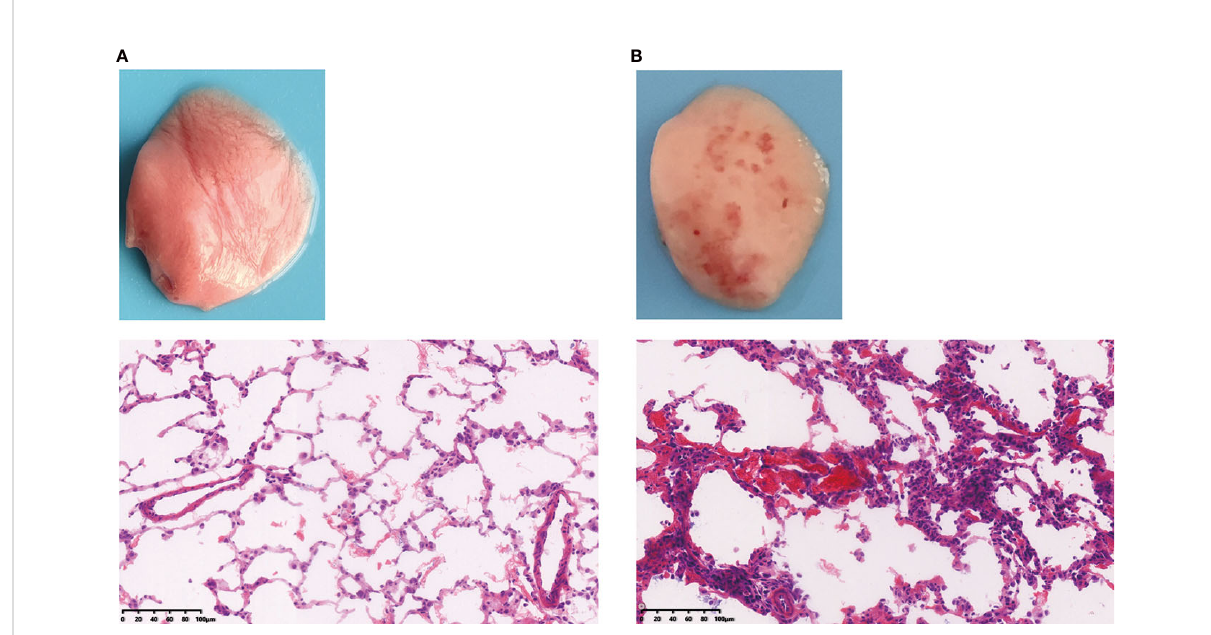
FIGURE 4 Rat lung tissues were compared to assess the difference between (A) healthy and (B) phosgene-induced acute lung injury after 24 hours of exposure. Rats were euthanized under ether anesthesia, and lung tissue from each experimental group was processed for histopathological evaluation